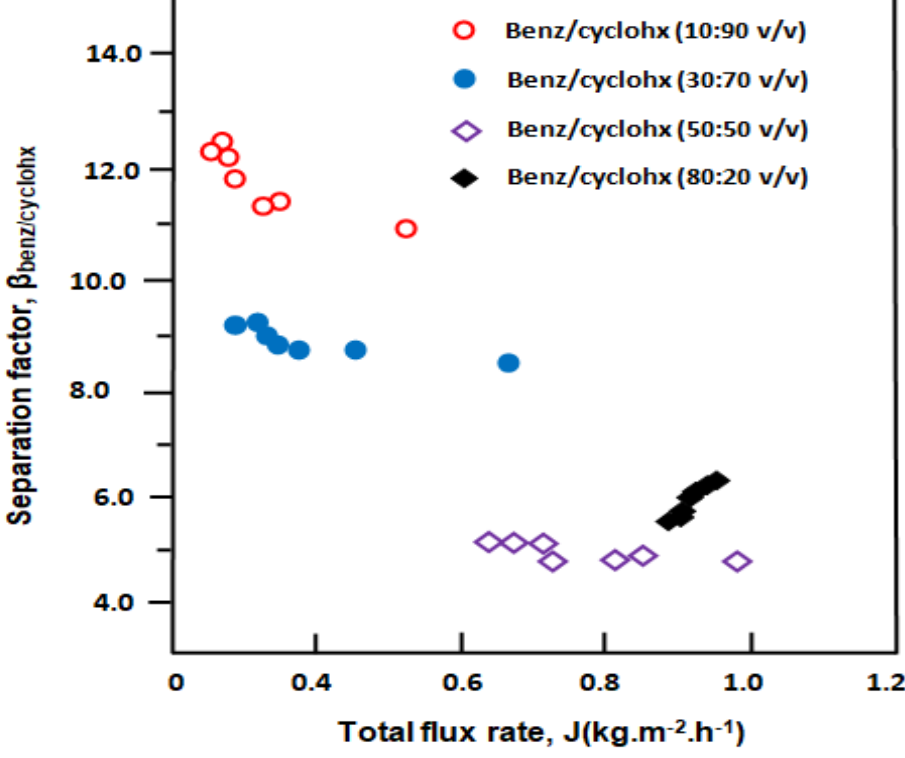
Figure 14. Change in the separation factor for benzene/cyclohexane mixture with different compositions versus total flux rate in the E-VOH/CNT-membrane.